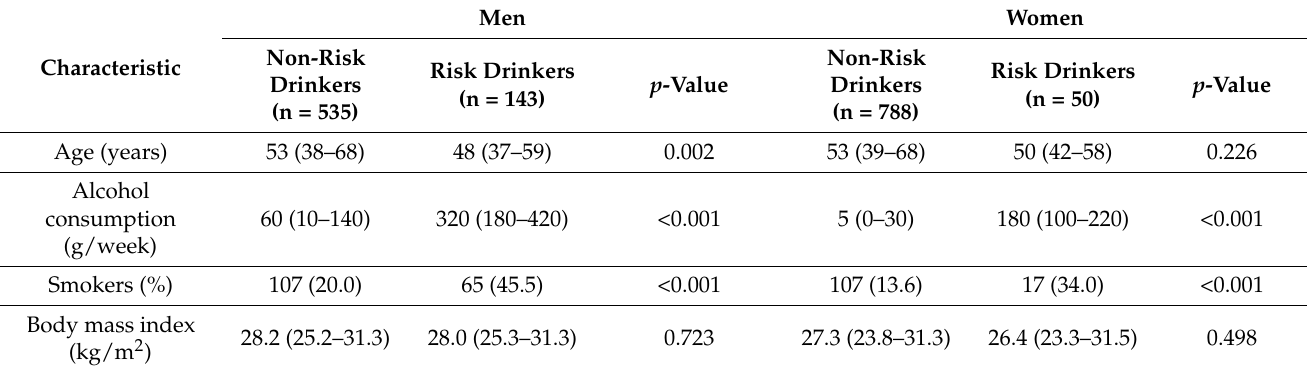
Table 1. General characteristics of risk drinkers and non-risk drinkers, stratified by